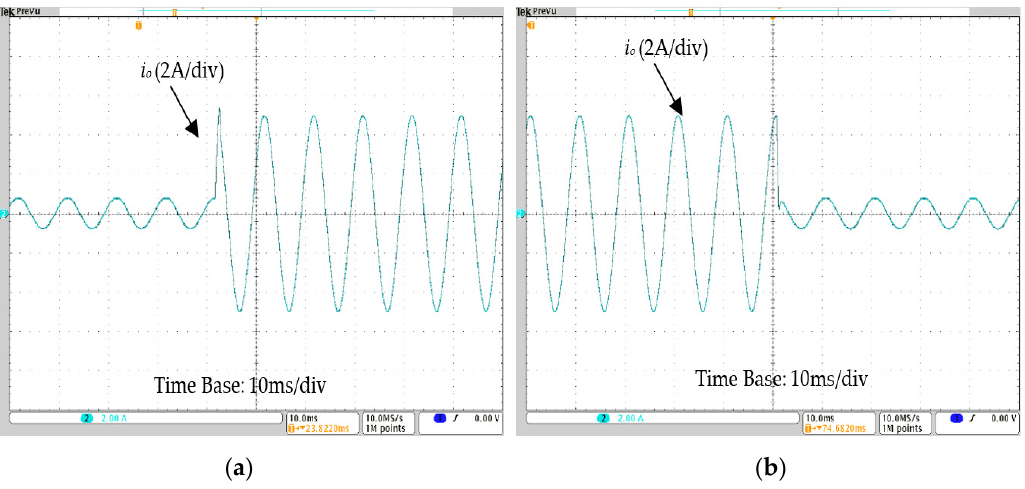
Figure 22. Experimental results of the load dynamic response: ( a ) a step change from 12.5% to 62.5% rated output power; ( b ) a step change from 62.5% to 12.5% rated output power.